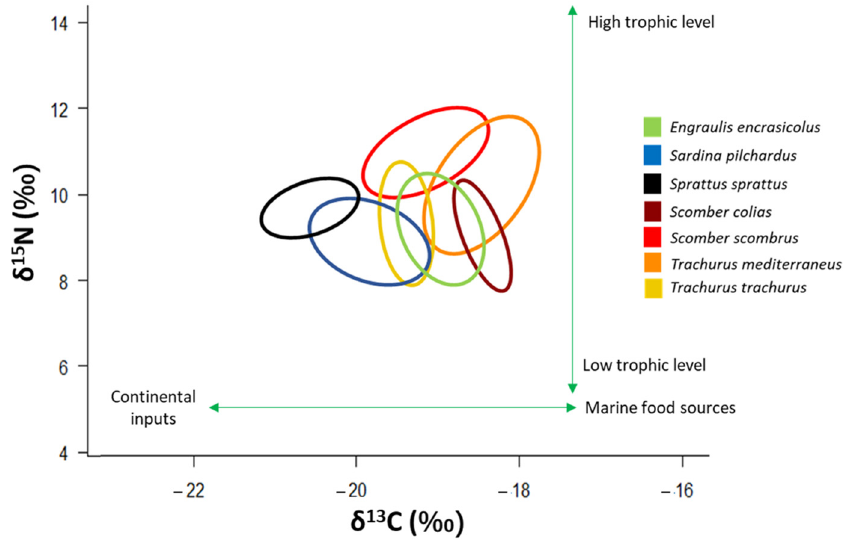
Figure 7. δ 13 C- δ 15 N scatterplot with standard ellipses corrected for small sample size population (SEA C, ‰ 2 ) overlaid for the specimens of the four “ancillary” species, and of the three small pelagic species that typify the central part of the pelagic food web in the Adriatic Sea. Signatures of E. encrasicolus , S. pilchardus and S. sprattus are taken from [2].